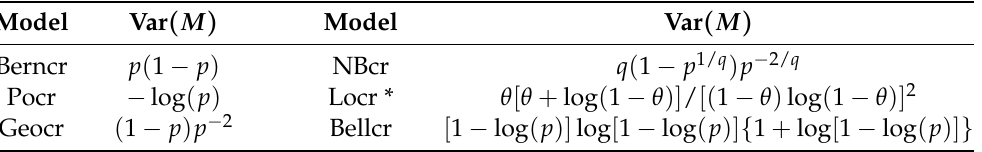
Table 1. Variance of the number of competing causes as a function of the cure rate for some models parameterized in the cure rate ( p ).